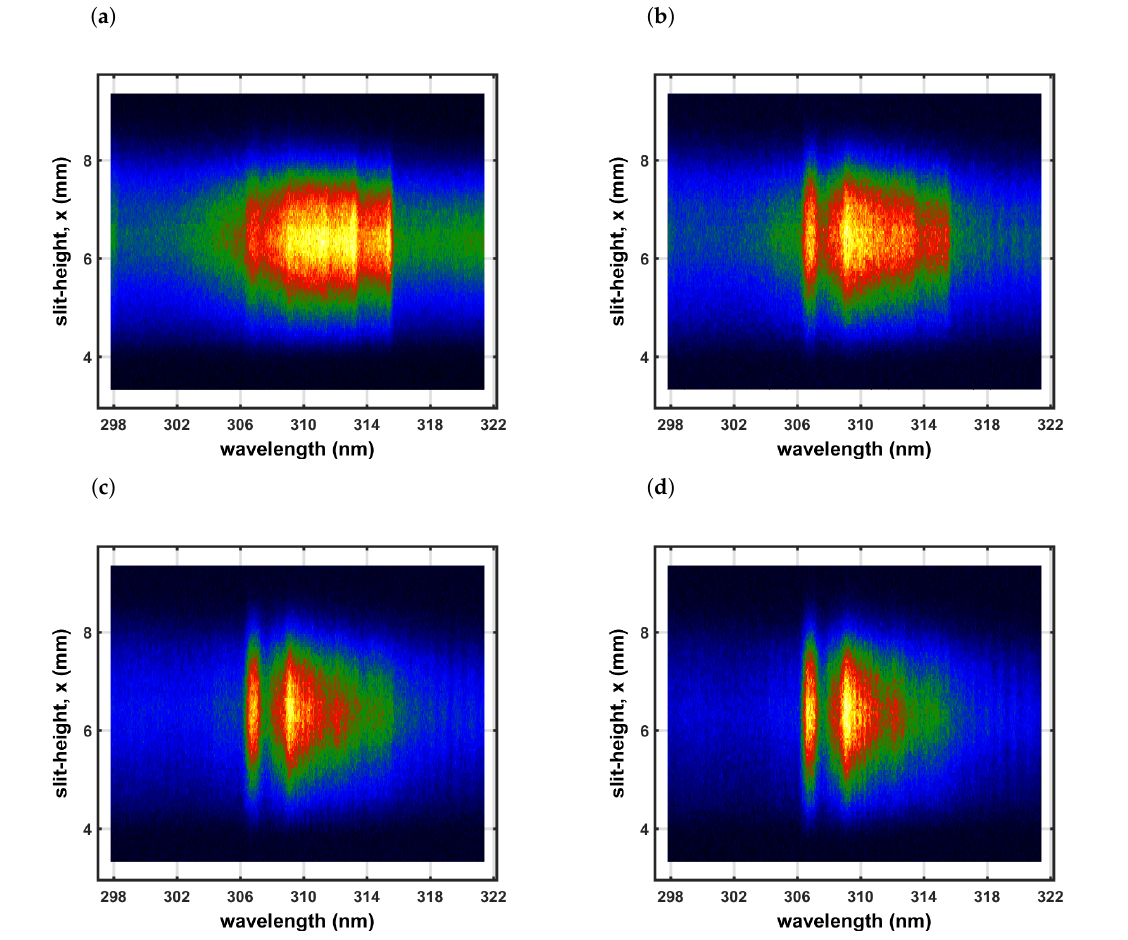
Figure 5. Recorded data of slit-height vs. wavelength. Gate width: 10 µ s, time delay ( a ) 20 µ s—primarily N 2 second positive spectra, ( b ) 30 µ s, ( c ) 40 µ s, and ( b ) 50 µ s—primarily OH spectra. Each displayed image is scaled from minimum to maximum and pseudo-colored using a rainbow